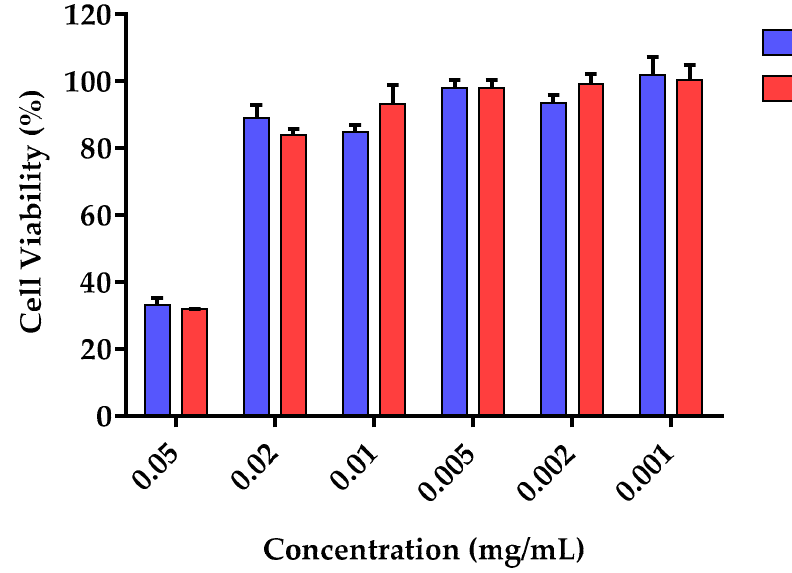
Figure 2. Percentage of cellular viability of immortalized human keratinocytes (HaCaT) cell line exposed to PGZ-limonene and limonene.